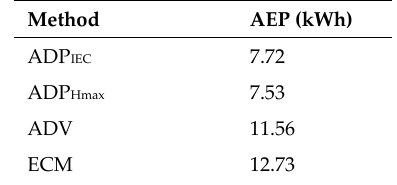
Fig 5. Velocity Probability Distribution for each instrument (and method) across all ebb